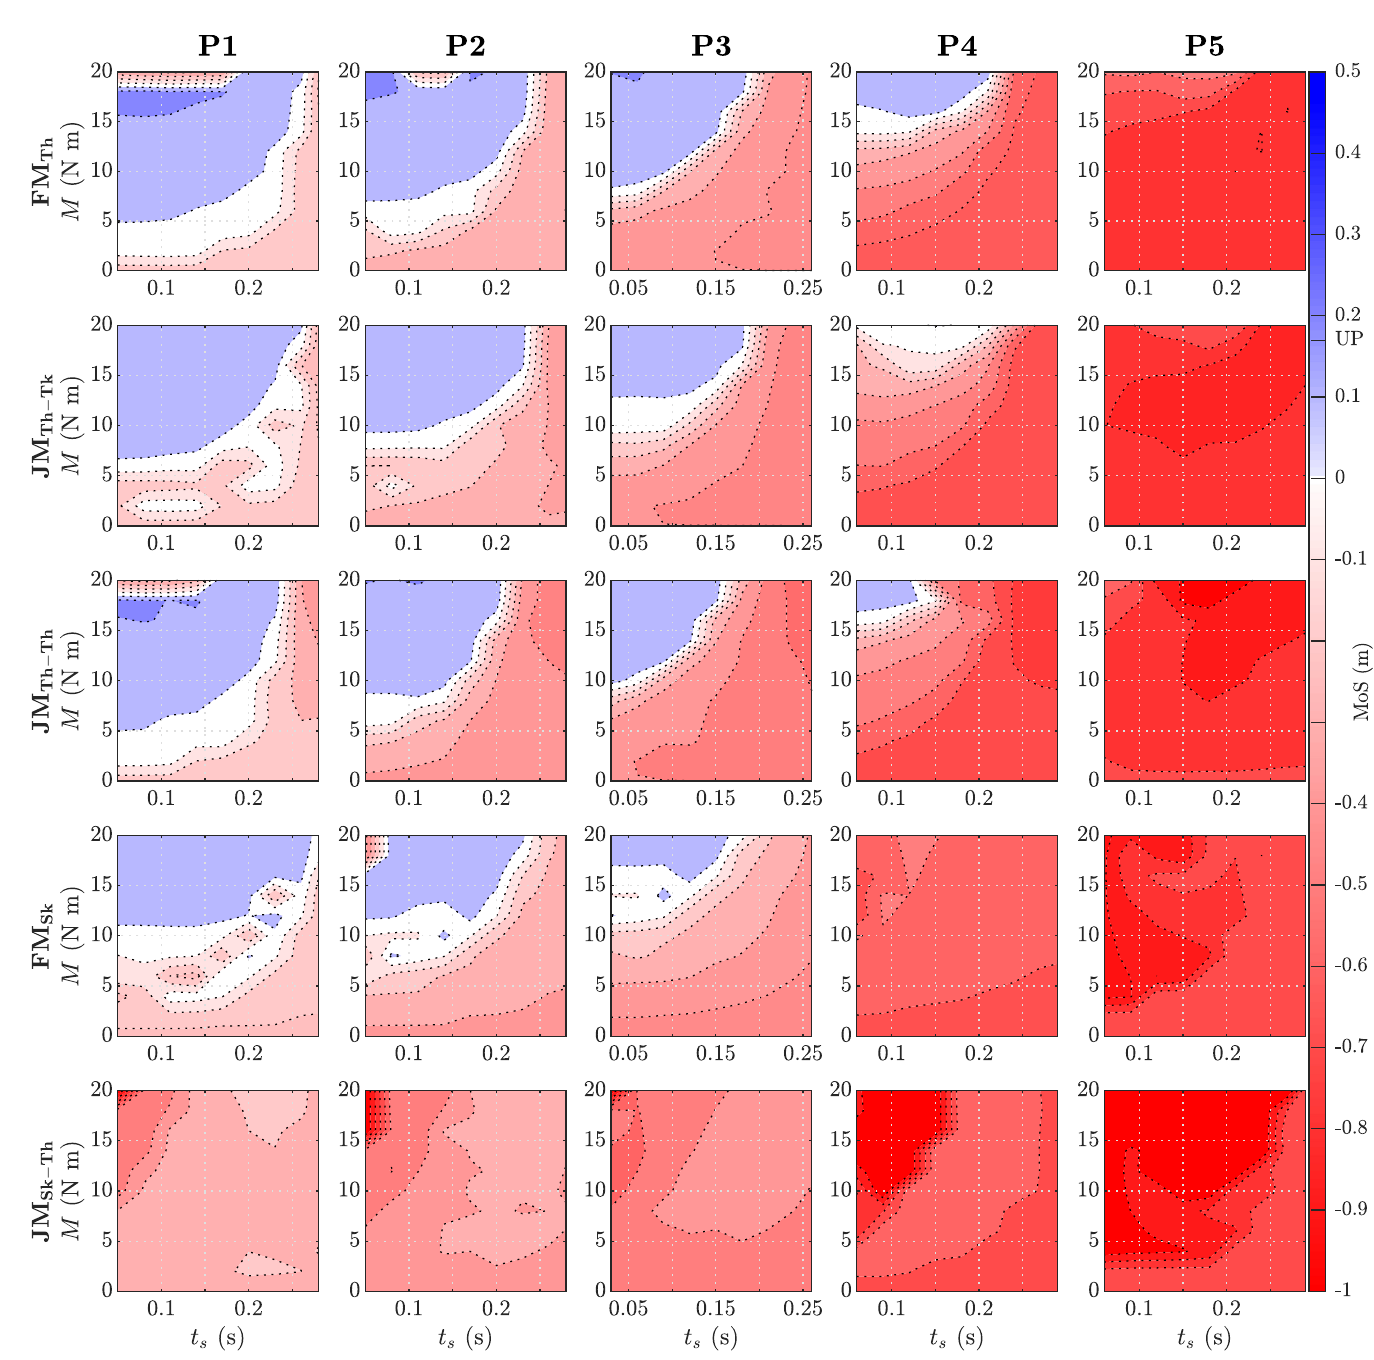
Fig 5. Margin of stability (MoS) as a function of assistance parameters (magnitude M and start time t s ). The minimum anterior MoS is taken at the heel-strike of the second step after perturbation. Negative values of the MoS are shown in red and positive values are shown in blue, with both colour intensities increasing with magnitude. The MoS during unperturbed (UP) gait is indicated in the colour scale on the right. The recovery responses of a free moment with action on thigh (FM Th ), joint moment with action on thigh and reaction on trunk (JM Th-Tk ), joint moment with action on thigh and reaction on contralateral thigh (JM Th-Th ), free moment with action on shank (FM Sk ), and joint moment with action on shank and reaction on thigh (JM Sk-Th ) to perturbations P1–5 are shown.